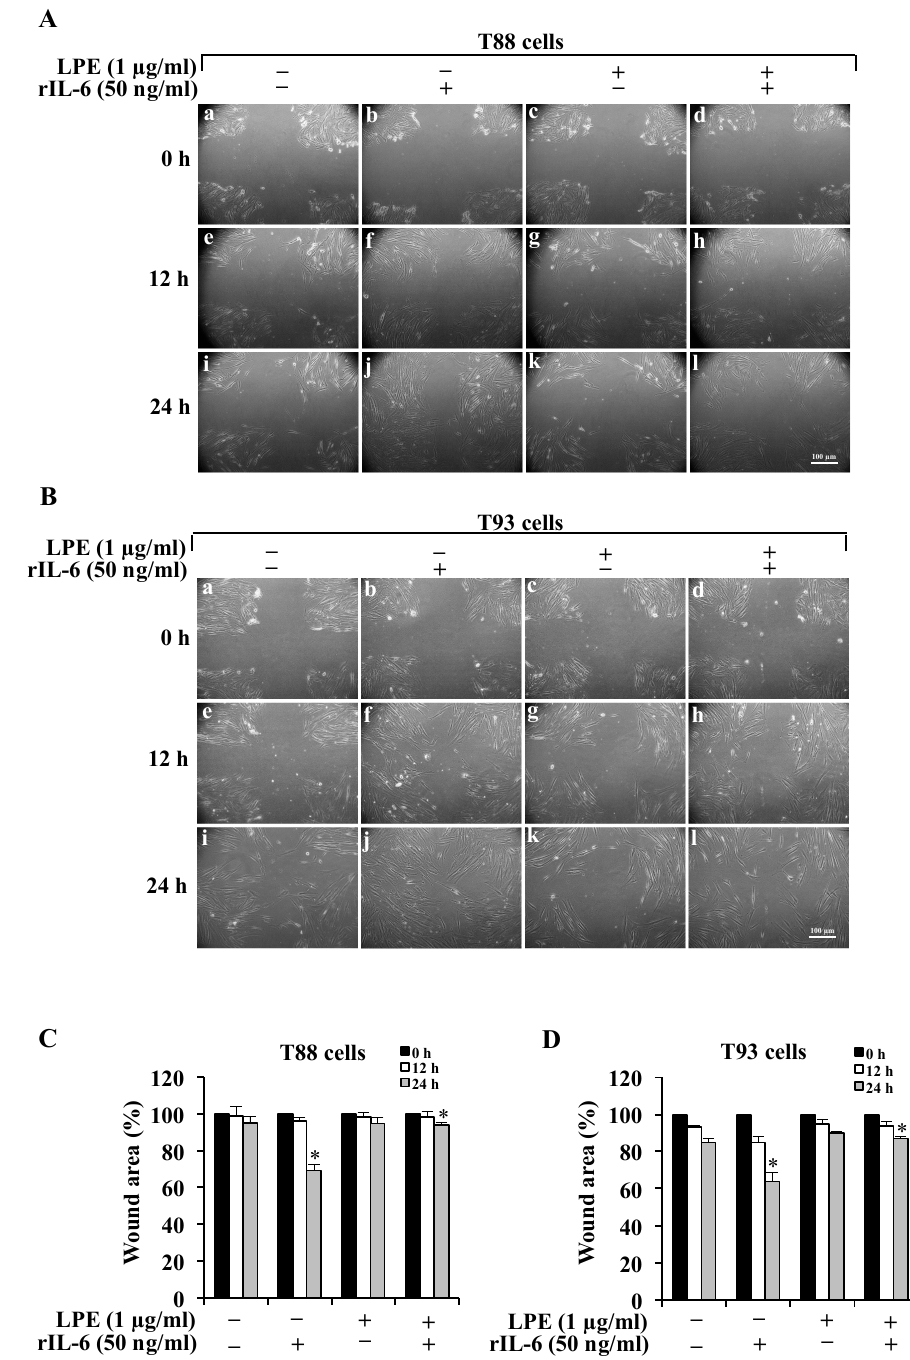
Figure 1. Effect of rIL-6 exposure with or without LPE pretreatment on the cell migration of T88 and T93 cells by wound healing assay. Representative images of ( A ) T88 and ( B ) T93 cells captured at time 0, 12, and 24 h by a phase-contrast microscope (10 × objective). Cells kept in serum-free DMEM ( a , e , i ) were treated with rIL-6 alone ( b , f , j ), LPE alone ( c , g , k ), or pre-treated with LPE (1 µ g/mL GAE) for 6 h and then the medium was removed and replaced with the same amount of fresh medium containing rIL-6 (50 ng/mL) for 12 h or 24 h. Quantitative analysis of the wound area of T88 ( C ) and T93 cells ( D ) at time 0, 12, and 24 h. For each treatment, the data shows the wound area at the indicated time in comparison to that of the open wound at time 0, set at 100%. Results are presented as mean ± SD ( n = 3) (* p < 0.05, statistically significant vs. untreated cells).